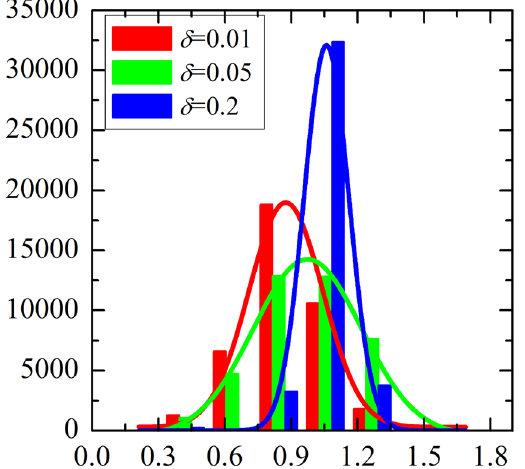
Figure 4. Stationary average size of cooperators cluster ( S = . b